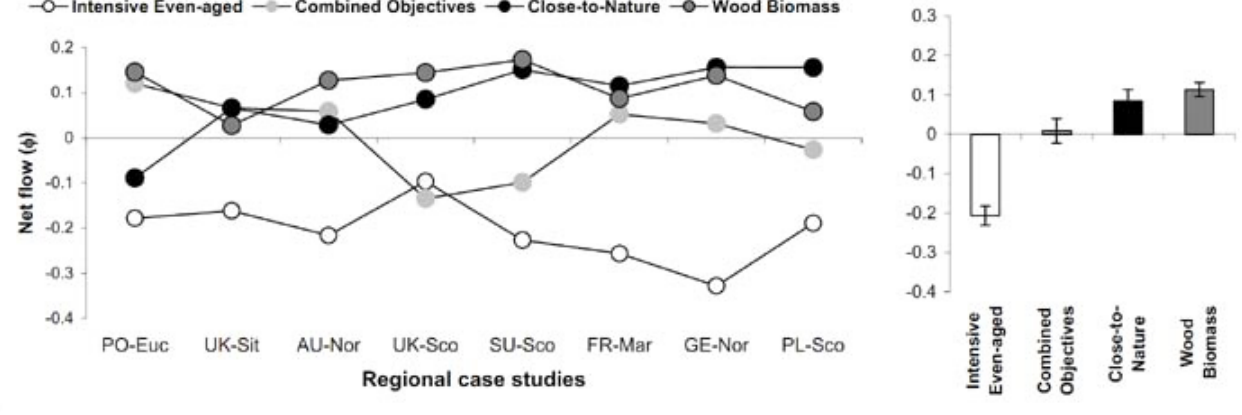
significant differences in FMA ranking among the eight regional case studies (Q